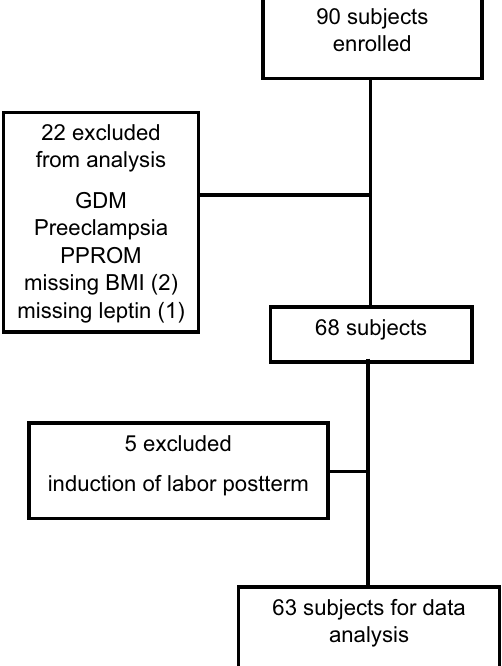
Figure 1. Number of participants enrolled and included in analysis. GDM = gestational diabetes mellitus. PPROM = preterm premature rupture of